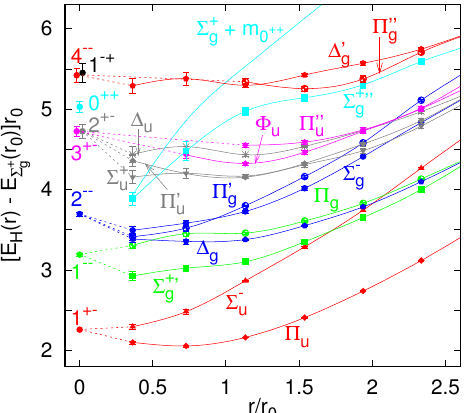
Figure 1. Quenched lattice NRQCD results for the heavy quark-antiquark static energy spectrum from Ref. [1]. Figure from Ref.